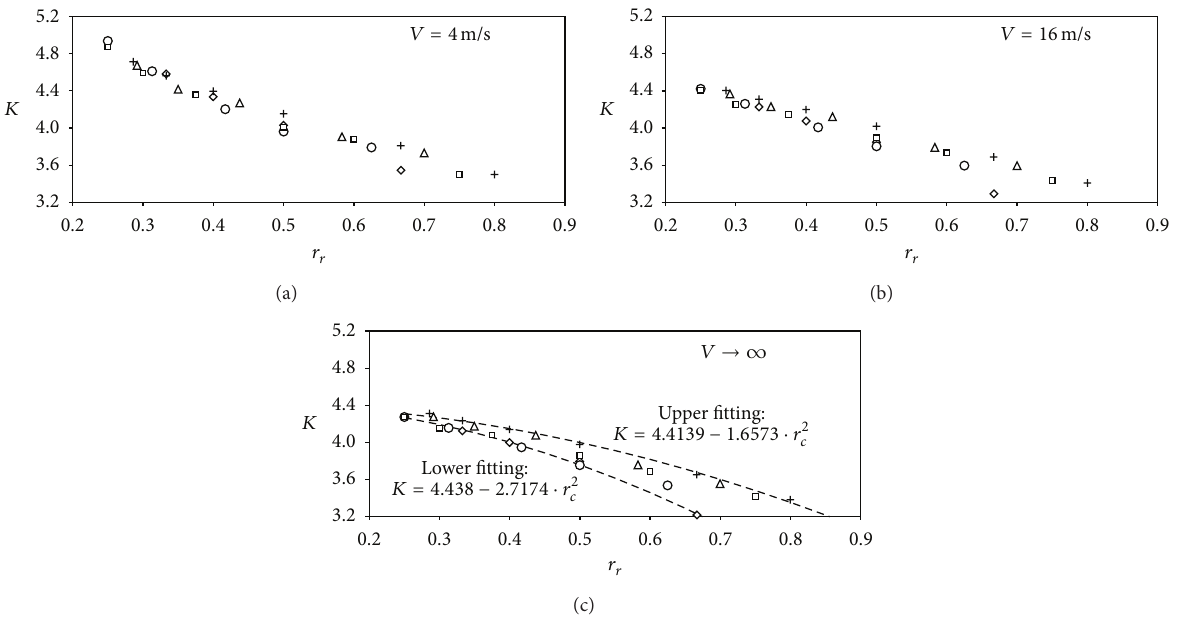
Figure 4: Anemometer factor, 𝐾 , regarding the conical cups rotors, calculated for 𝑉 = 4 m/s (a), 𝑉 = 16 m/s (b), and 𝑉 → ∞ (c), as a function of the parameter 𝑟 𝑟 ( 𝑟 𝑟 = 𝑅 𝑐 /𝑅 𝑟𝑐 ). The symbols correspond to rotors equipped with the following cup radii: 𝑅 𝑐 = 20 mm (rhombi), = 25 mm (circles), 𝑅 = 30 mm (squares), 𝑅 = 35 mm (triangles), and 𝑅 = 40 mm (crosses). The quadratic fittings to 𝑅 𝑅 𝑐 𝑐 𝑐 𝑐 (lower fitting) and to 𝑅 𝑐 = 40 mm rotors (upper fitting) have been also added (dotted lines) to the bottom graph.